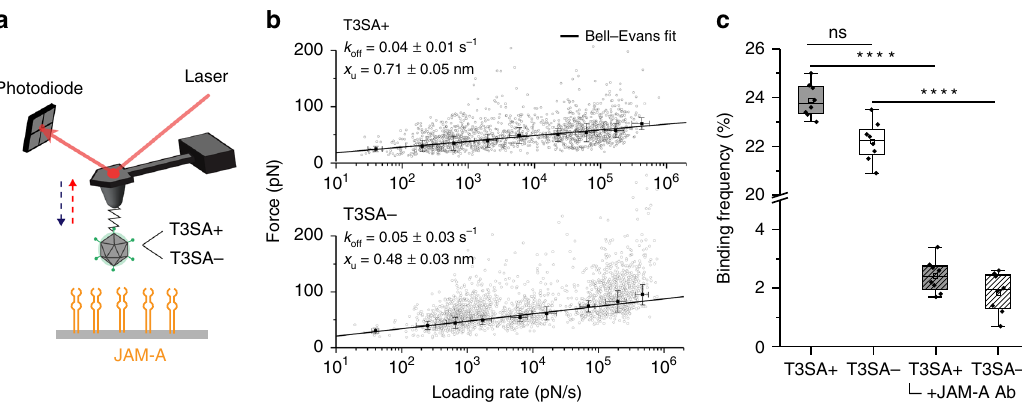
Fig. 4 Probing reovirus binding to JAM-A on model surfaces. a Binding of single virions (T3SA + or T3SA − ) to JAM-A probed on a model surface. b DFS plot showing the force required to separate T3SA + (upper panel) or T3SA − (lower panel) virions from JAM-A and fi tted with the BE model. Error bars indicate s.d. of the mean value. For all experiments, data are representative of at least n = 5 independent experiments. c Box plot of the binding frequency of reovirus to JAM-A model surface. T3SA + interactions are shown in grey, T3SA − in white, and hatched boxes represent injection of 10 µ g/mL JAM-A antibody (Ab). The horizontal line within the box indicates the median, boundaries of the box indicate the 25th and 75th percentile, and the whiskers indicate the highest and lowest values of the results. The square in the box indicates the mean. ns, P > 0.05; **** P < 0.0001; determined by two-sample t- test in Origin. Source data are provided as a Source Data fi